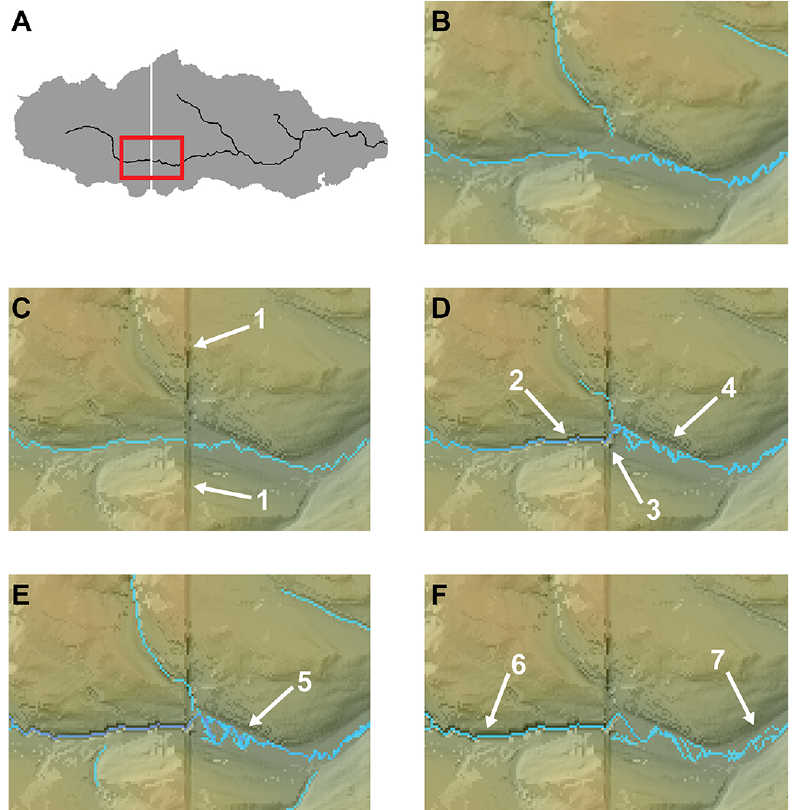
Figure 5. Geomorphic changes occurring after the 50m instantaneous uplift scenario. (A) location of fault (solid white line) and area selected for elevation maps (red rectangle). (B–F) Elevation maps of selected area, respectively after 47.9, 50.1, 55.5, 63.5 and 99.2yr of simulation. Arrows indicate specific features: 1. Escarpment after uplift; 2. Incision of channel upstream of fault line; 3. Formation of small alluvial fan; 4. Braided river pattern downstream of fault line; 5. Expansion of braiding; 6. Continued incision upstream of fault line; 7. Downstream propagation of braided river